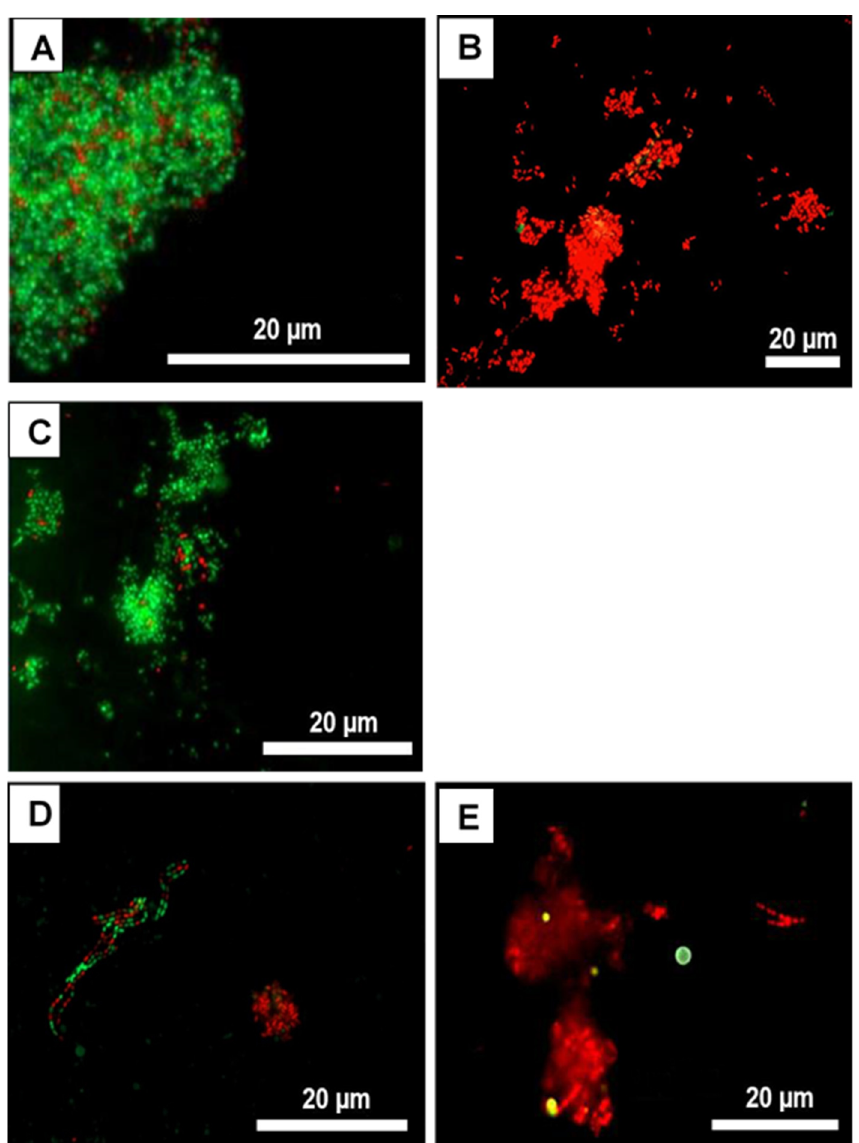
Figure 4. Fluorescence microscopy (FM) images after live/dead staining with BacLight ® . The vital bacteria fluoresce in green, the avital in red. The effects on the initial adhesion (2 h) after 10 min of 0.9% NaCl treatment (negative control) ( A ), 0.2% CHX treatment (positive control) ( B ), 10% DMSO treatment (toxicity control) ( C ), as well as after treatment with I. viscosa extract in two concentrations: 10 mg/mL ( D ) and 30 mg/mL ( E ), are shown.